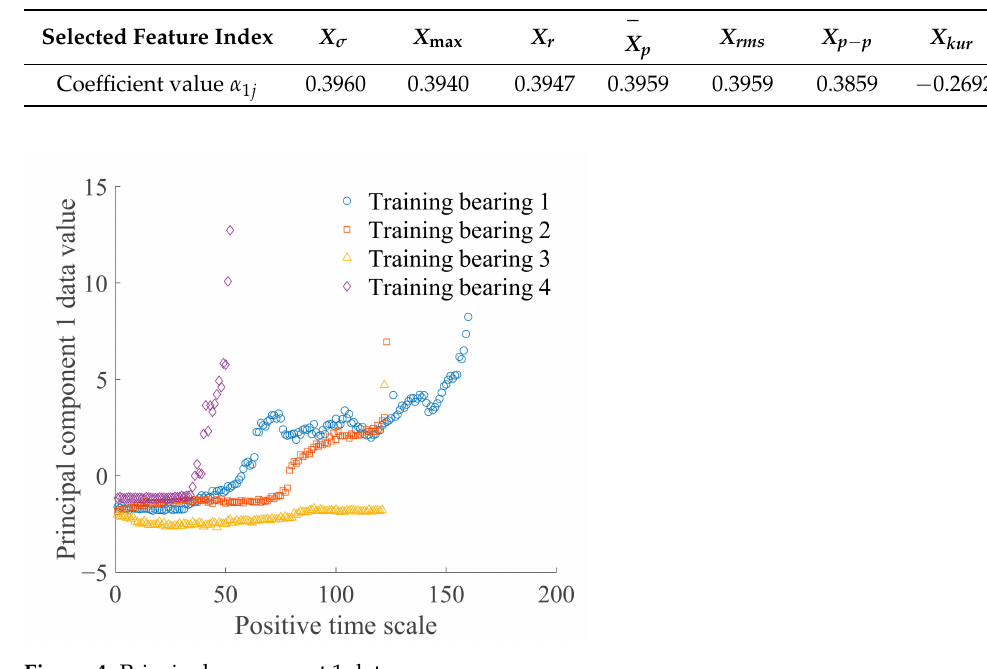
Figure 4. Principal component 1